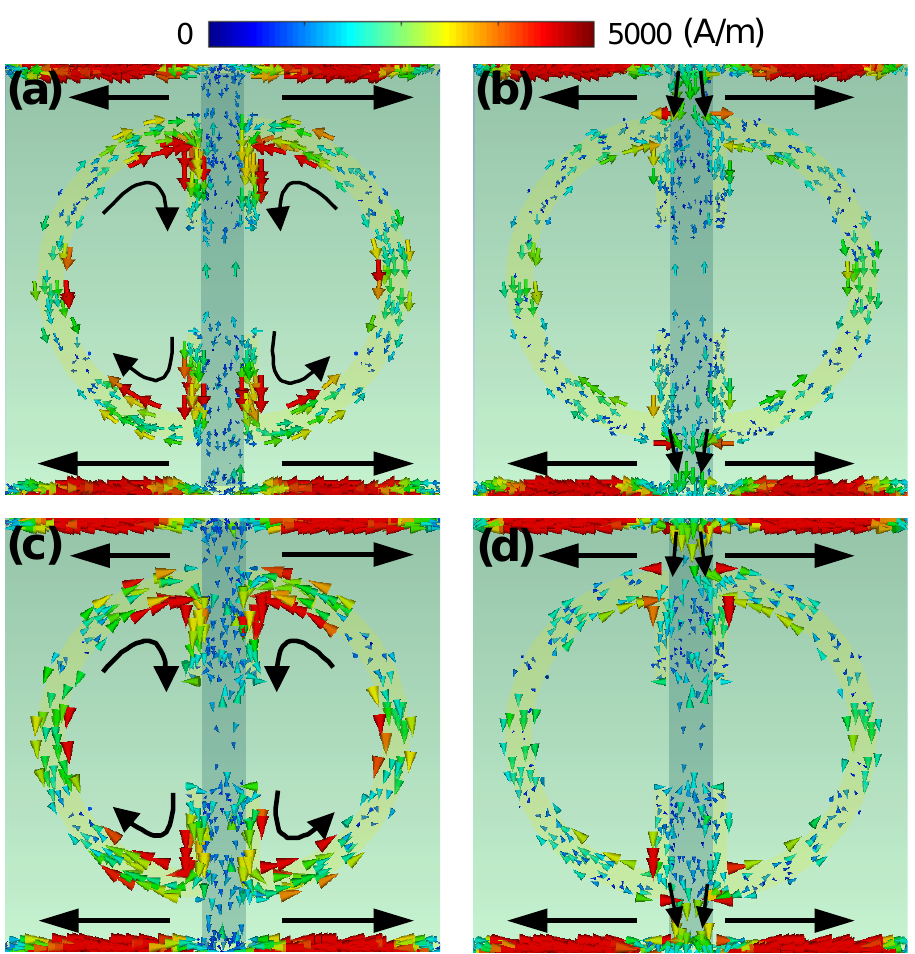
Figure 3. Surface current distributions of the metasurface with two typical graphene Fermi levels of ( a , b ) 0.6 eV for ( a ) 1.019 THz and ( b ) 1.1 THz and ( c , d ) 1.2 eV for ( c ) 1.068 THz and ( d ) 1.136